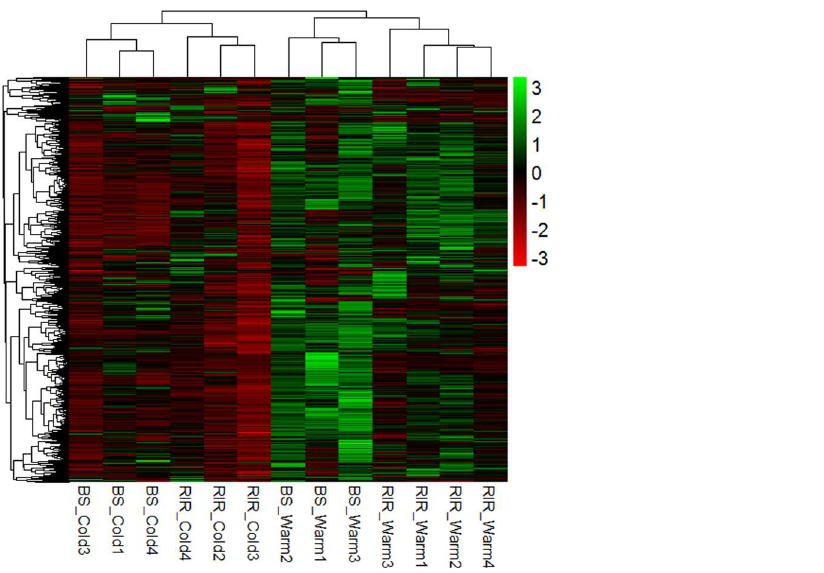
Fig 6. Heatmap of differentially spliced